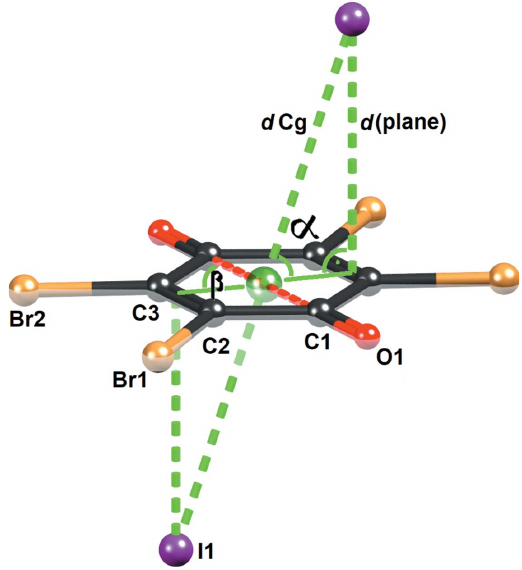
Figure 1 Sandwich-like I (cid:3) (cid:2)(cid:2)(cid:2) Br 4 Q (cid:2)(cid:2)(cid:2) I (cid:3) unit in 1 with geometric parameters indicated. Symmetry-independent atoms are labelled.